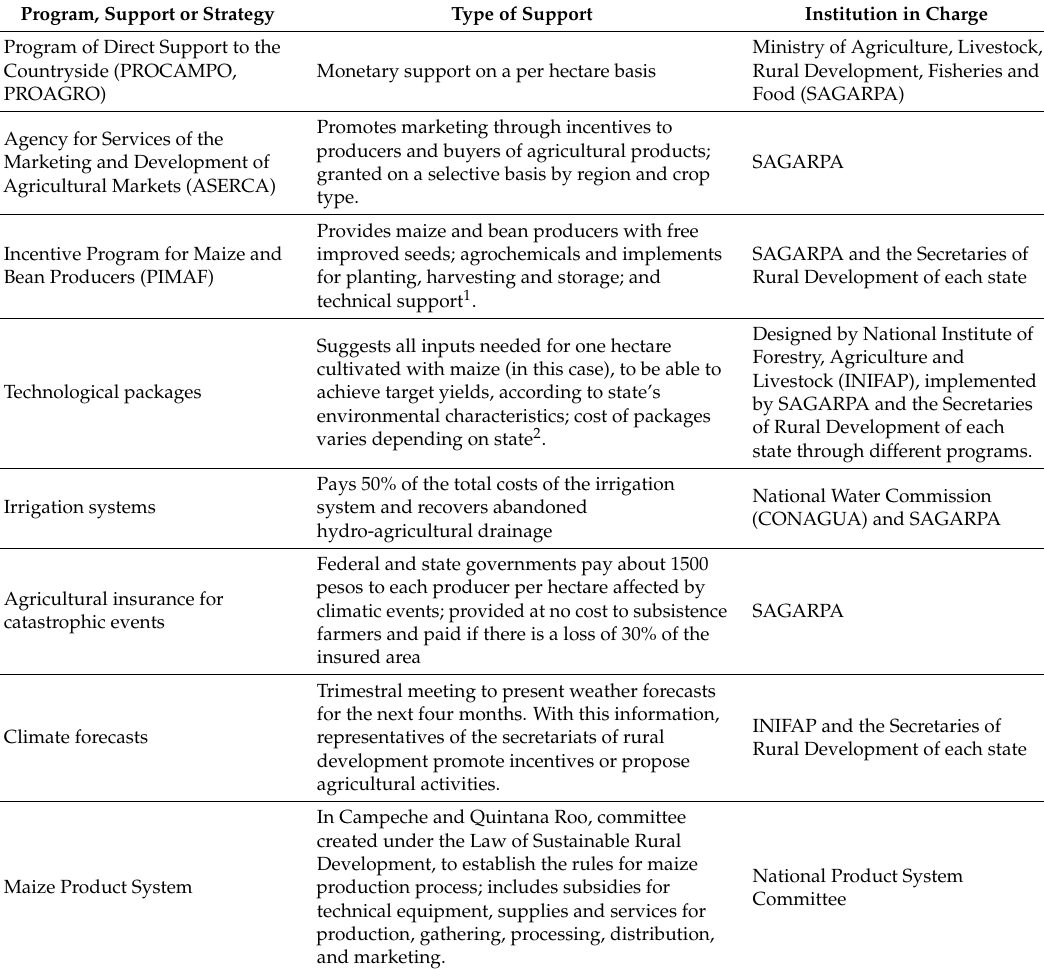
Table A1. Programs, supports and strategies used by maize producers in Mexico’s Yucatan